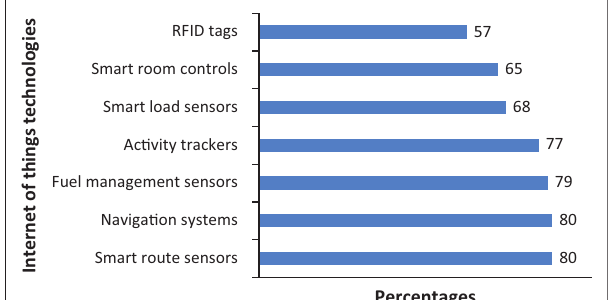
FIGURE 2: Internet of things technologies identified by